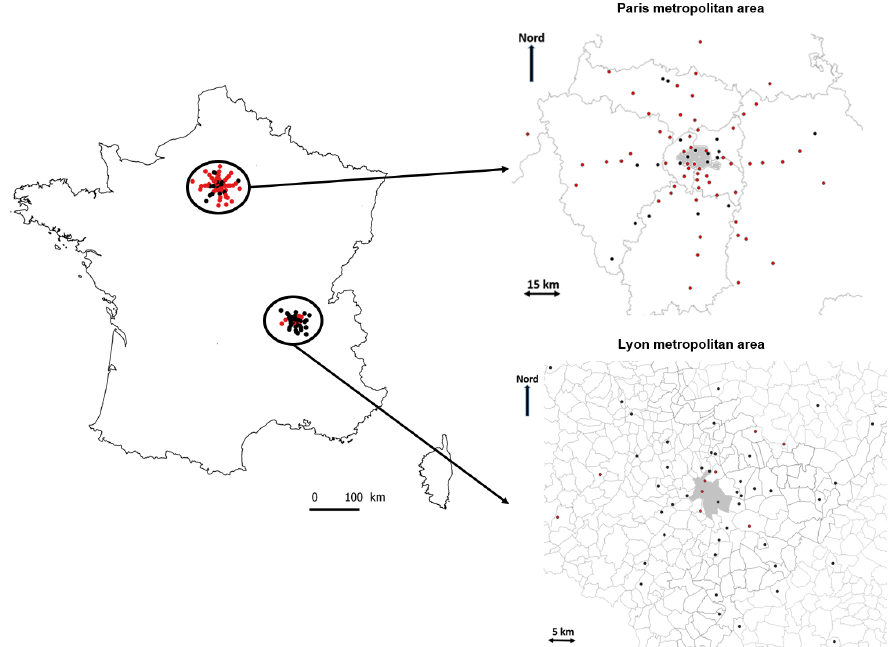
Figure 1. The studied metropolitan areas: cemeteries sampled in the Paris and Lyon metropolitan areas (above, the municipality of Paris; below, the municipality of Lyon). Red point: mosses collected from graves; black point: mosses collected from